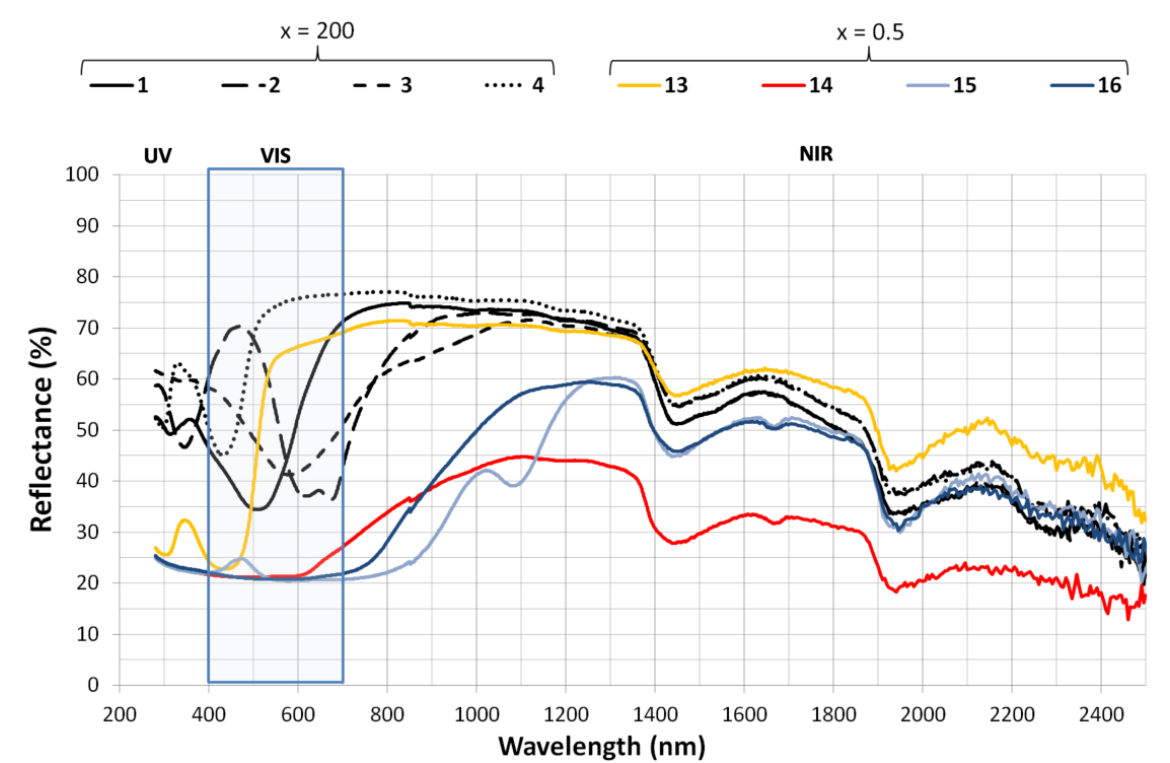
Figure 3. TSR (%) for each hybrid at maximum and minimum dye loading.